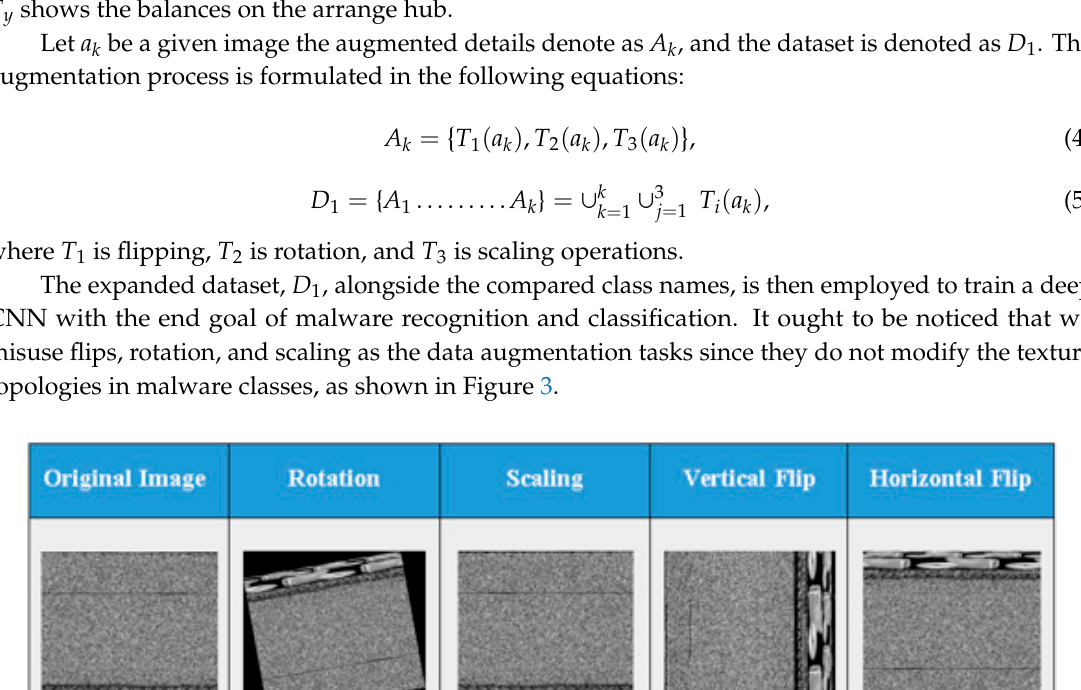
Table 2. Affine transformation matrices for image augmentation.